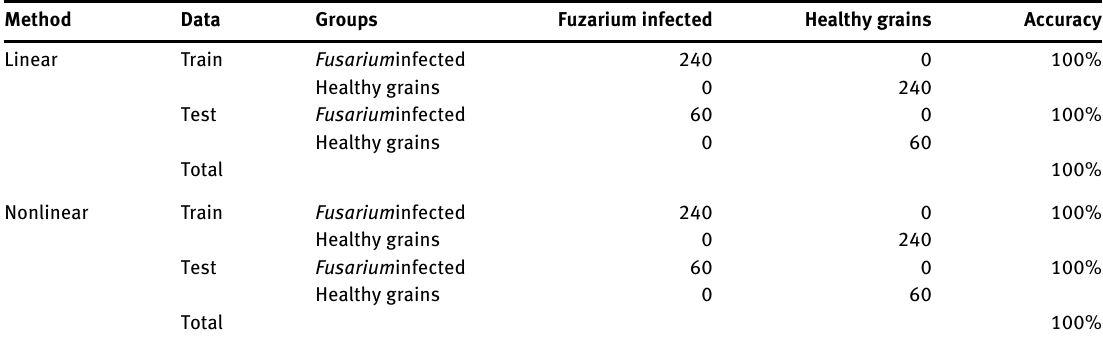
Table 6: The Results of Grain Classification with Linear and Nonlinear SVM Algorithm for Texture Values.